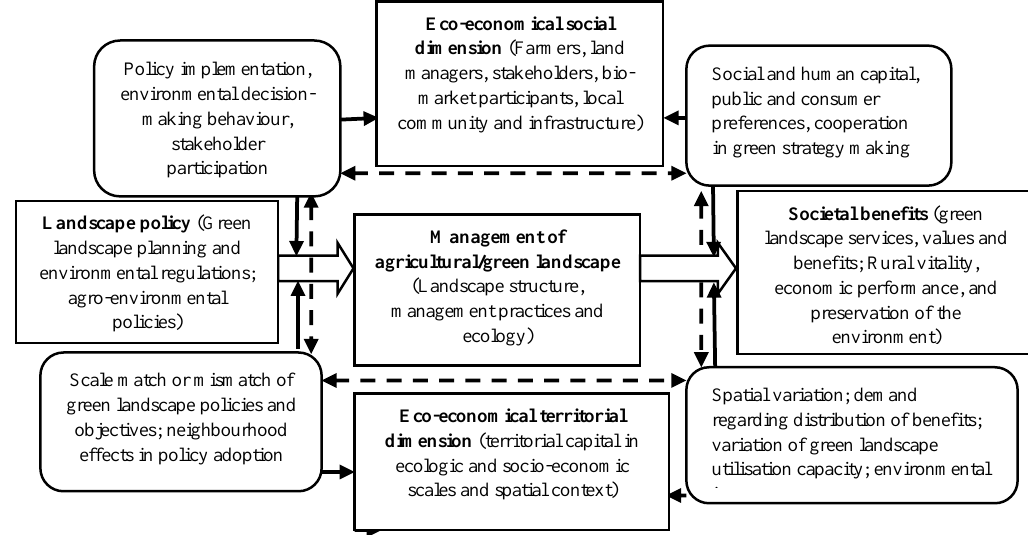
Fig. 5. Landscape development model in rural areas (made by the